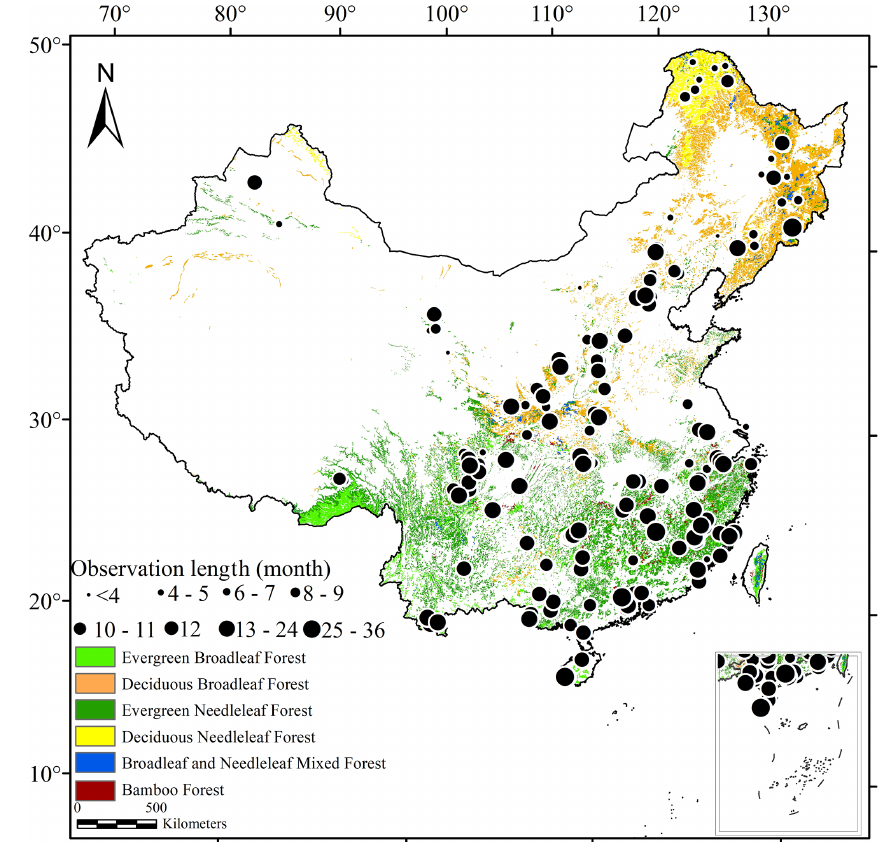
Figure 1. Distribution of study sites used to develop the forest soil respiration dataset in